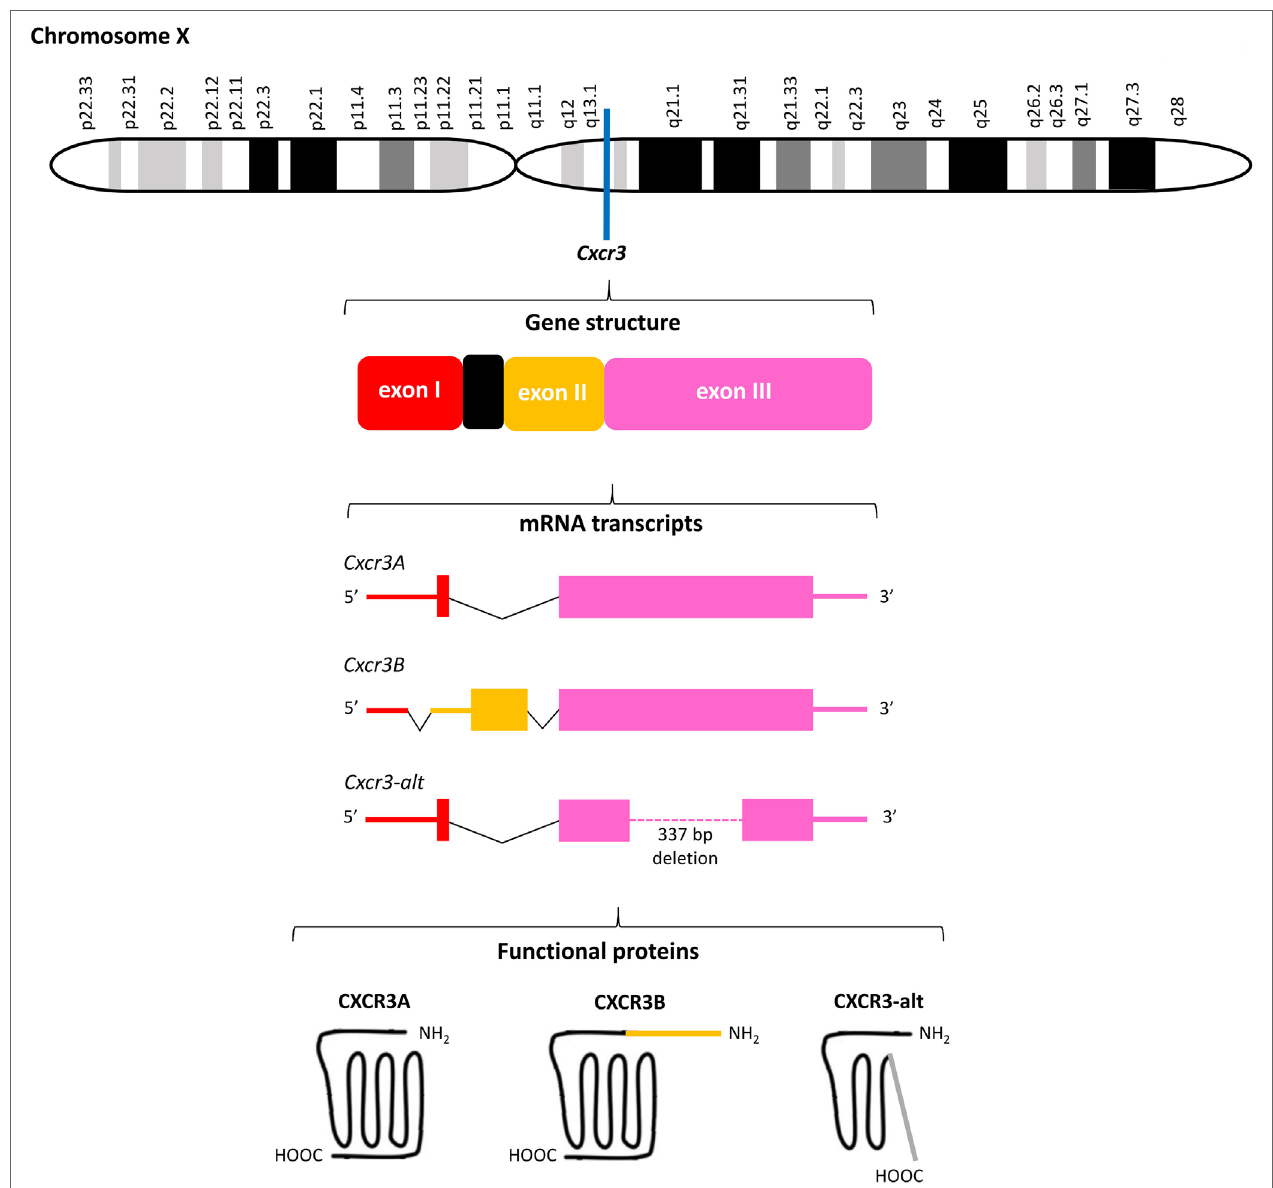
FiGuRe 3 | Overview of the Cxcr3 gene structure. Cxcr3 is located at the q13.1 region on chromosome X and contains three exons and one intron. Alternative splicing generates three mRNAs encoding three structurally and functionally different CXC chemokine receptor 3 (CXCR3) proteins. The canonical CXCR3A contains 368 amino acids. The four most NH 2 -terminal residues are encoded by exon I of Cxcr3 and all remaining amino acids are encoded by exon III. CXCR3B (415 amino acids) contains a unique NH 2 -terminal tail of 51 amino acids encoded by exon II. Both CXCR3A and CXCR3B contain seven transmembrane domains. The significantly shortened CXCR3-alt (267 amino acids) results from posttranscriptional exon skipping and contains only four or five transmembrane